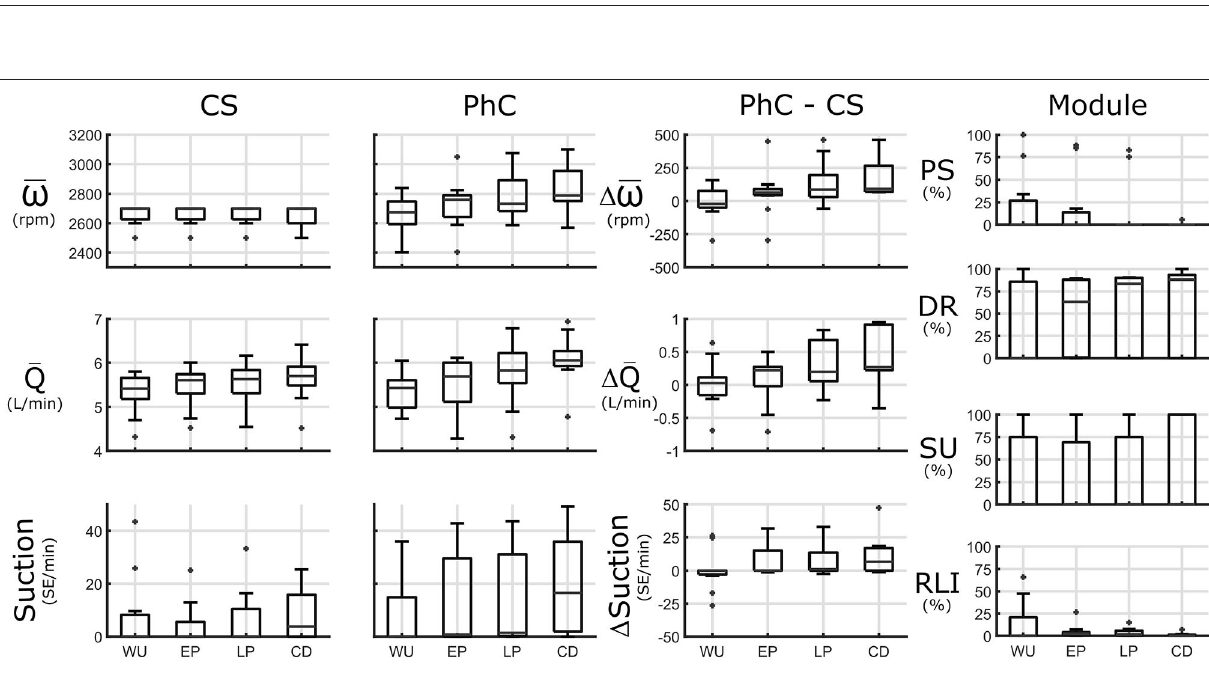
FIGURE 4 | Orthostatic transitions from the supine position to either sitting or standing. Left panels: Speed ( ω ), flowrate (Q), and suction [in Suction Events (SE)/minute] in constant speed (CS) and physiologic control (PhC) and their differences are presented in steady state (SS) initial transition phase (IP) and late phase (LP). Module panel: control module activation: activation for pulsatility (PS), demand response (DR), suction response (SU), and rate limited increase (RLI) modules. Speed is reduced in PhC compared to CS in all phases. Lower suction burden in IP and LP is observed. There is predominant DR activation at SS with increasing contributions of the PS and SU module at later stages of the